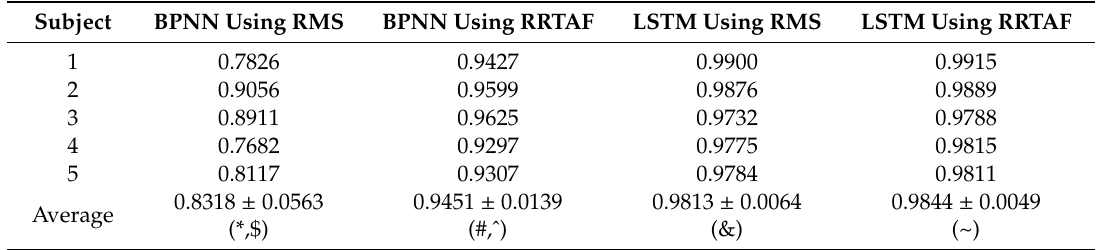
Figure 10. Comparison of the RMSEs between the estimated angle and the actual angle of knee joint obtained by the four methods (BPNN using RMS, BPNN using RRTAF, LSTM using RMS, LSTM using RRTAF) from subject 1 to subject 5. Table 4. Cross-correlation coe ffi cient ρ obtained by the four methods for each